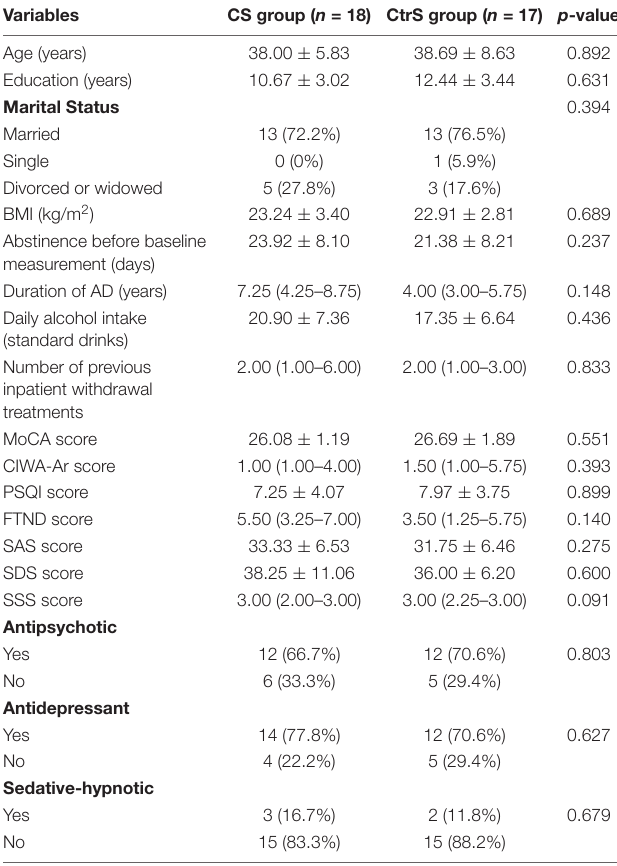
TABLE 1 | Demographic and clinical characteristics of the subjects in the CS and CtrS groups.